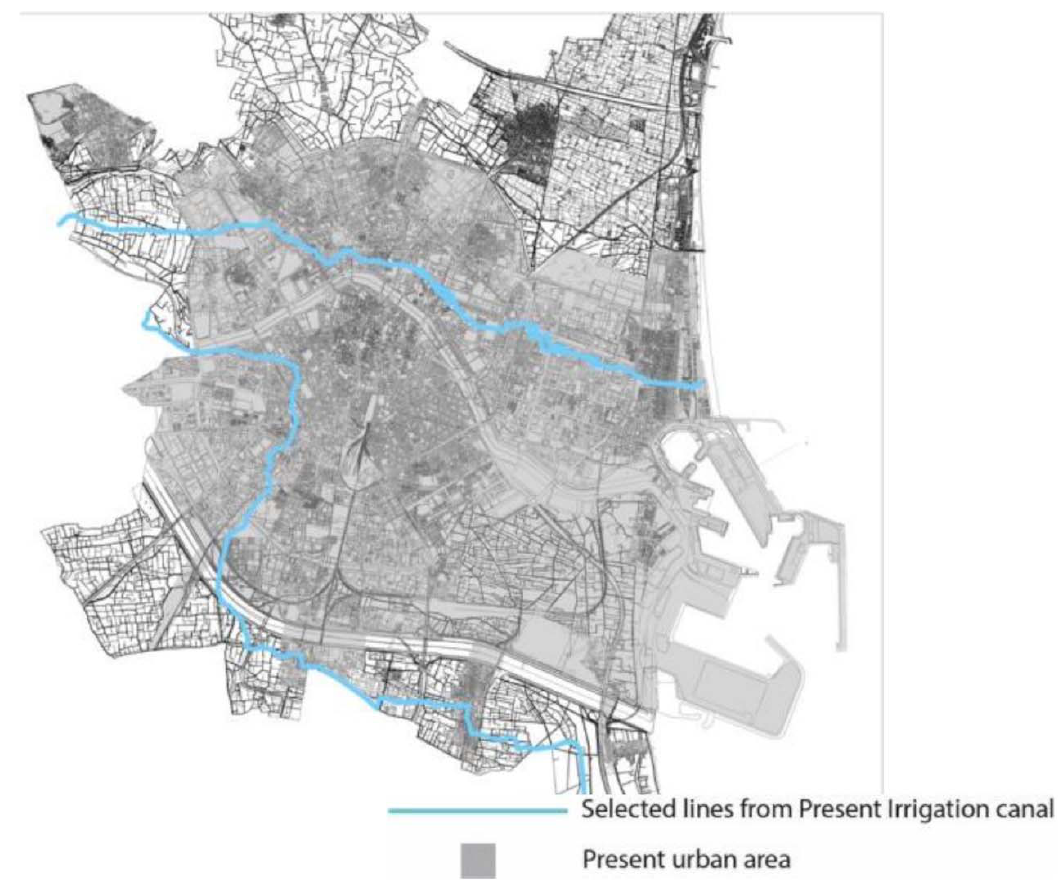
Figure 3. The target area for the field survey and urbanized